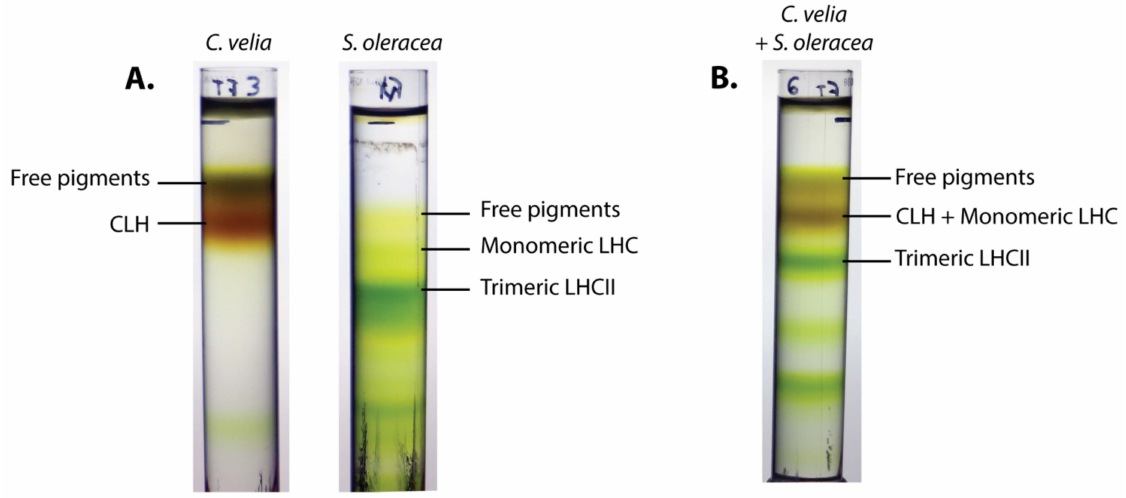
Figure 2. Separation of solubilized thylakoid membranes from C. velia or S. oleracea (spinach) on sucrose gradients. ( A ) Solubilized thylakoids from each organism were deposited on identical sucrose gradients and centrifuged in the same conditions. The band corresponding to CLH antenna from C. velia laid just below the free pigments one, at a position correspondent to monomeric LHC antennas from spinach. ( B ) Membranes from both organisms were deposited and centrifuged on a single gradient, resulting in an apparent co-migration of monomeric LHC and